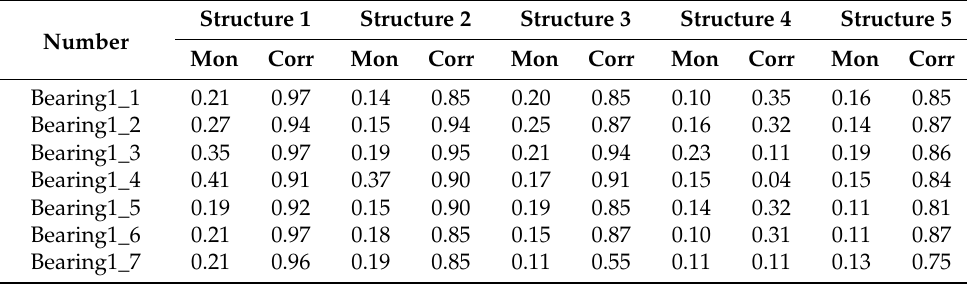
Table 4. Evaluation results of HI curves trained by five